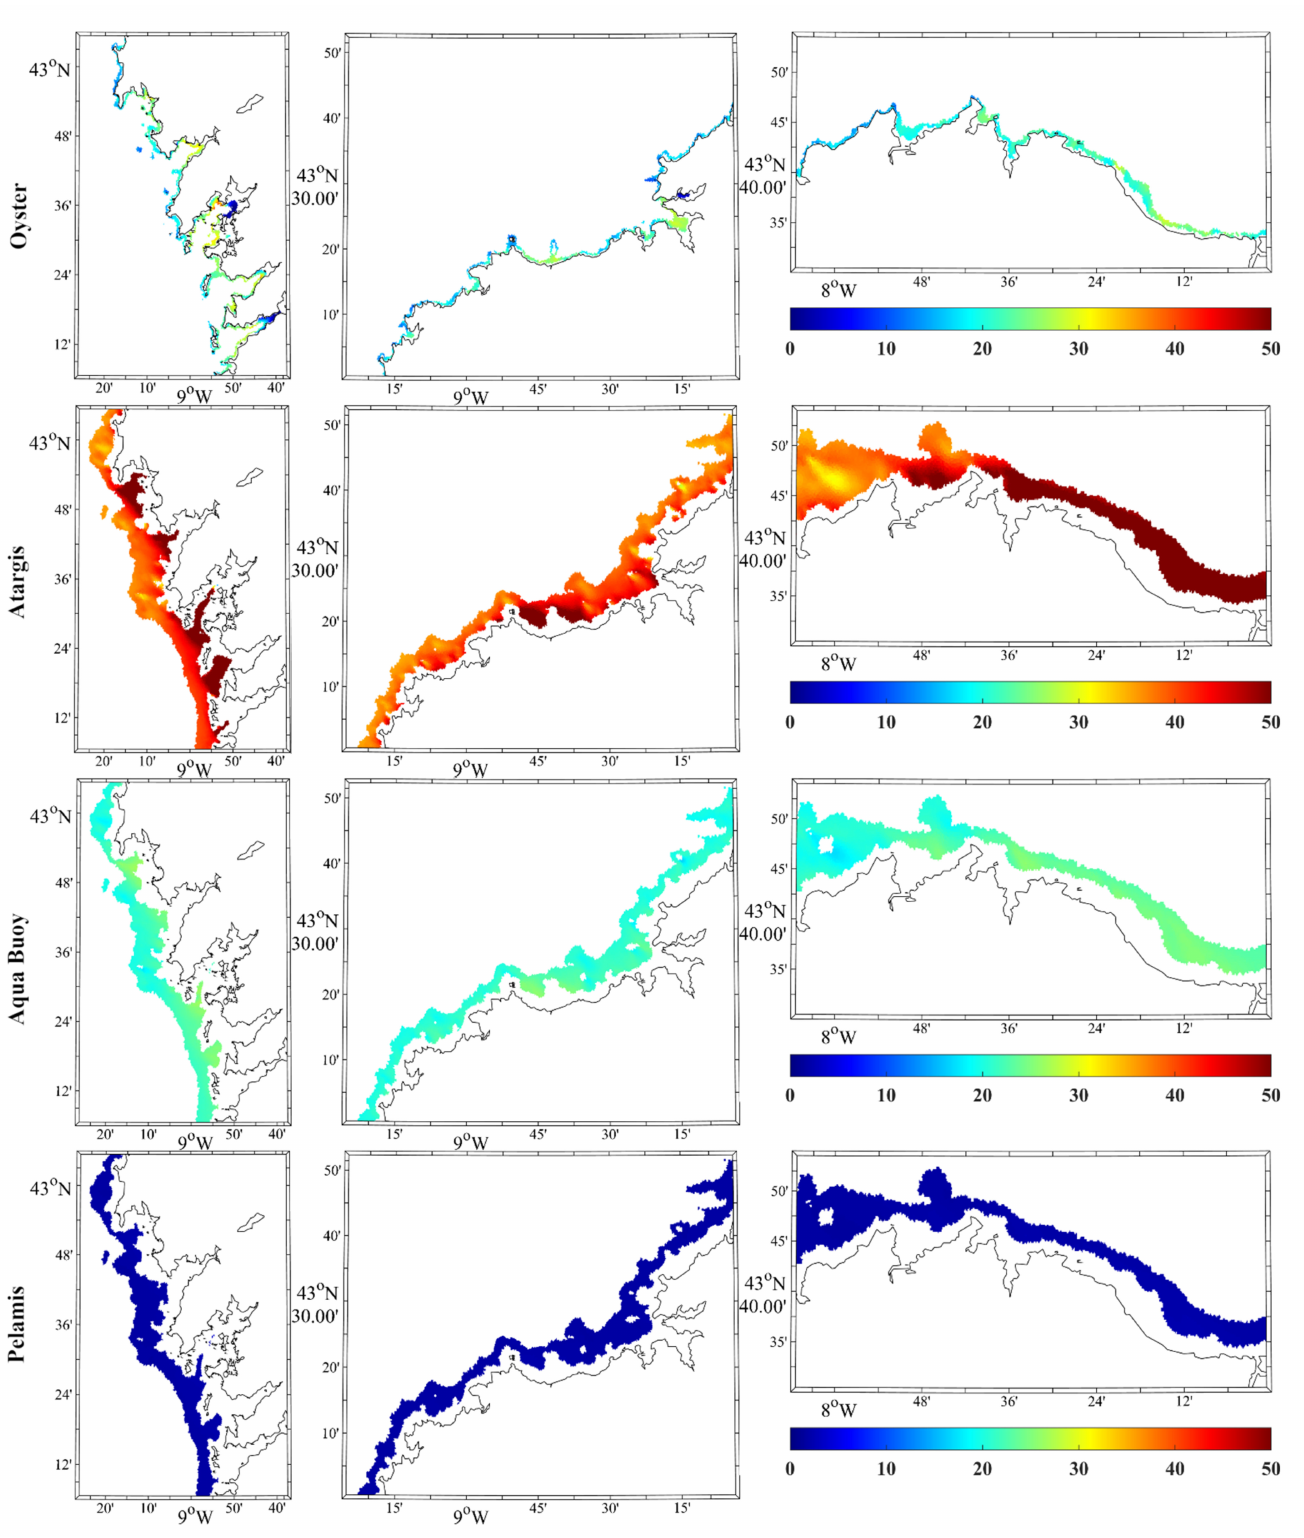
Figure 6. Efficiency (in %) of the Oyster, Atargis, Aqua Buoy, and Pelamis devices for the West Coast ( left column), the Northwest ( middle column), and the North Coast ( right column) for the period